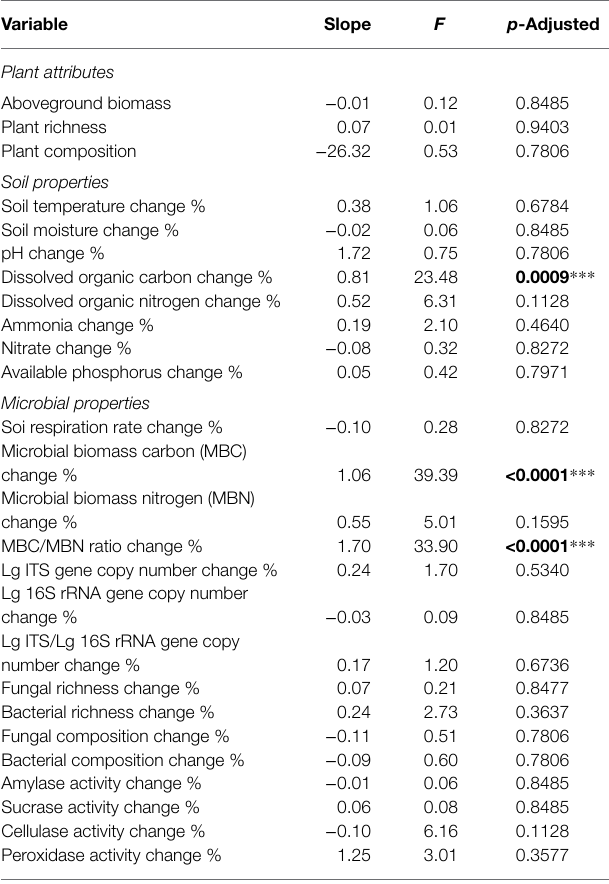
TABLE 2 | Relationships between the change of soil organic carbon with the change of plant attributes and soil and microbial properties during the growing